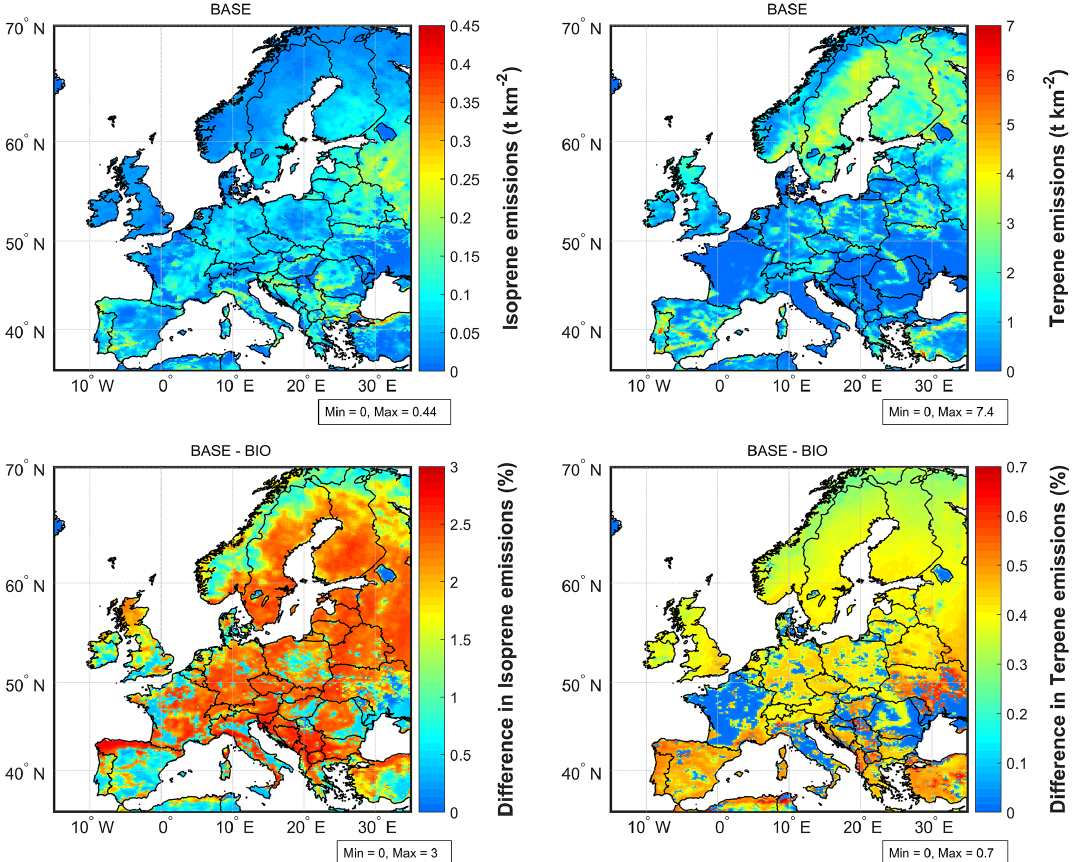
Figure 9. Total (i.e., JJA sum) of isoprene (left panels) and terpene (monoterpene and sesquiterpene; right panels) emissions per km 2 for the BASE scenario (top panels) and relative difference between BASE and BIO scenarios (bottom panels) in summer 2010.